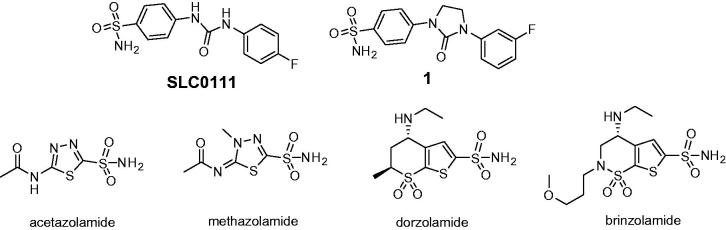
Advanced and clinically used hCA inhibitors.